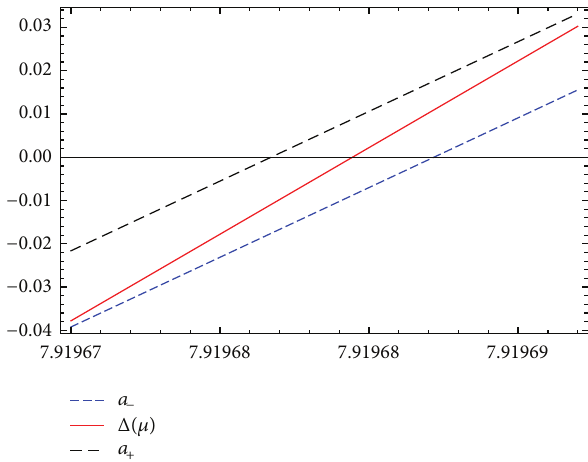
Figure 7: The enclosure interval dominating 𝜇 4 for 𝑚 = 14 , 𝑁 = 40 , 𝜃 = 1/26 , and 𝜀 = 10 −5 .